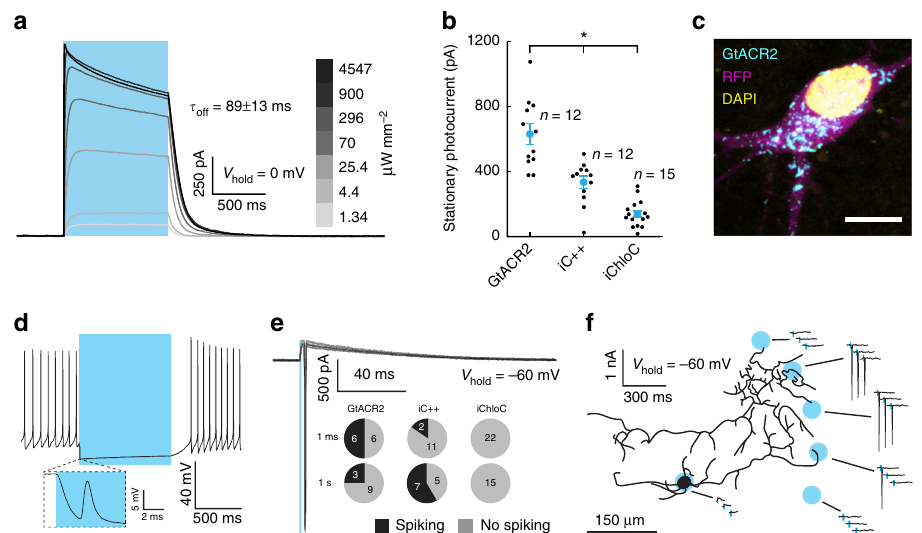
Fig. 1 GtACR2 shows greater photocurrents than eACRs, but triggers antidromic spiking in axons. a Sample whole-cell voltage-clamp photocurrent recording of a GtACR2-expressing cell illuminated (470 nm) with increasing light power density. Channel closing kinetics ( τ off ) was determined by a single exponential fi t ( I ( t ) = I 0 *e^(- t * τ off -1 ) + C , I 0 : Current measured at light offset, C : holding current at V hold ; mean ± SEM; n = 10). b Comparison of stationary photocurrents of blue light-sensitive ACRs ( V hold = − 35 mV, current after 1 s of continuous illumination). Neurons expressing GtACR2 ( n = 12) showed the highest photocurrents compared with neurons expressing iC + + ( n = 12) and iChloC ( n = 15). ANOVA, F (2,36) = 36.92, p = 1.9*10 − 9 . Data are presented as mean ± SEM. c Representative image of GtACR2 localization. Cyan: GtACR2, magenta: cytoplasmic RFP, yellow: DAPI. Scale bar, 10 µ m. d Representative whole-cell current-clamp recording of a GtACR2-expressing cell silenced by light application. Inset: strongly attenuated spike